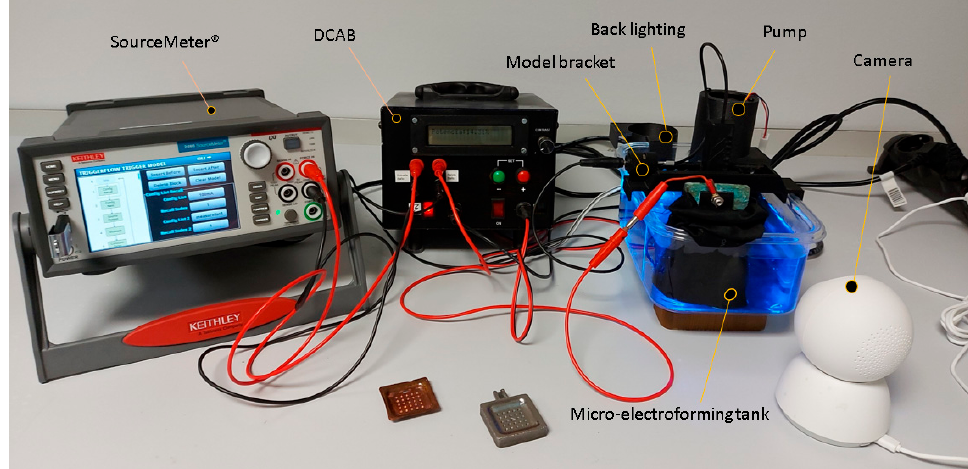
Figure 5. Electroforming equipment.